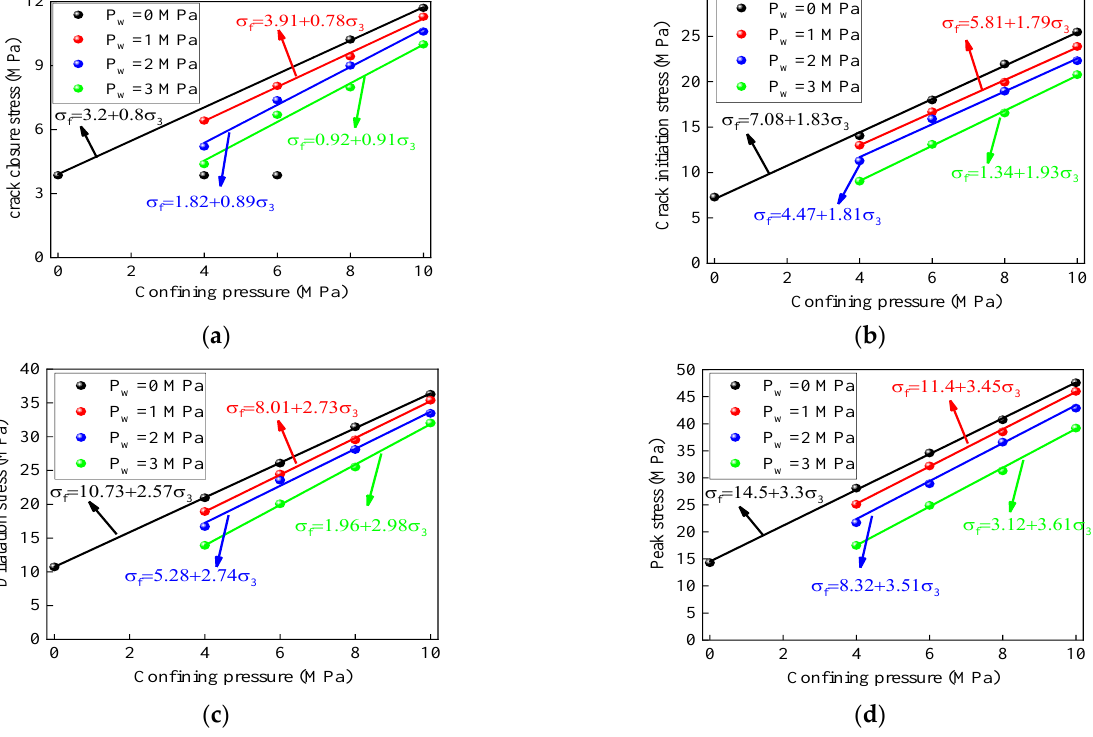
Figure 9. Variation curve of characteristic strength: ( a ) crack closure strength, ( b ) crack initiation stress, ( c ) dilatation strength, and ( d ) peak strength.